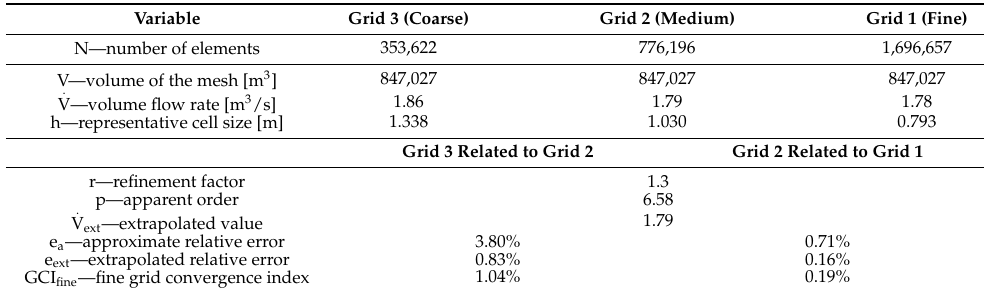
Table A1. Results from the reliability calculations of the generated